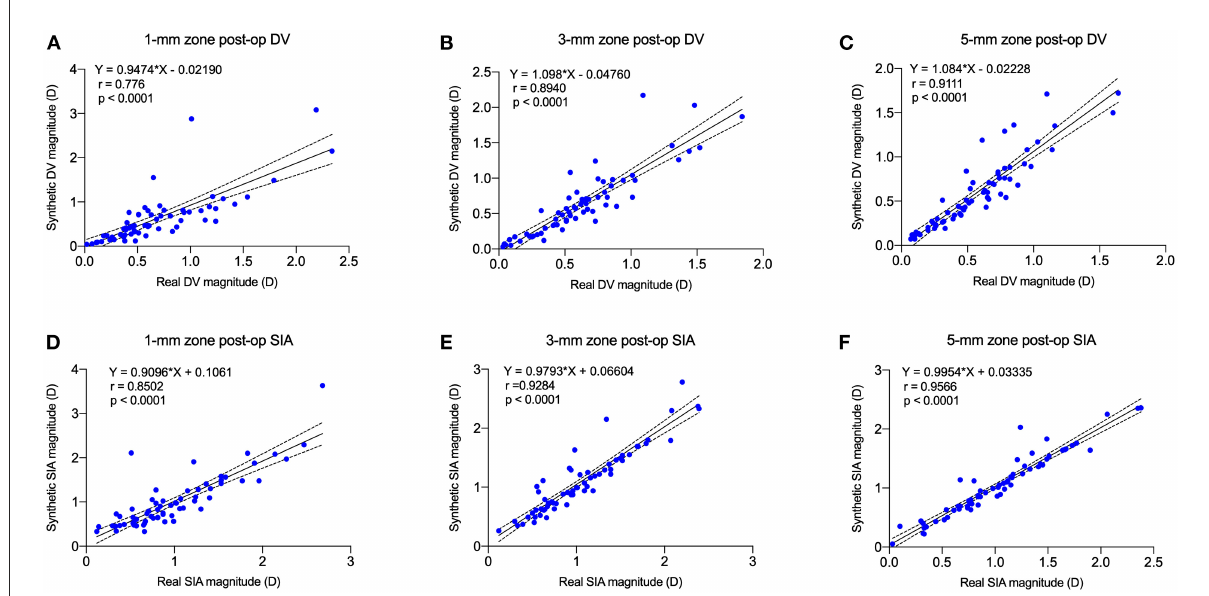
FIGURE7 Postoperative real vs. synthetic DV and real vs. synthetic SIA correlation graph for 1-mm, 3-mm, and 5-mm zones. (A) The correlation between real and synthetic DV in the 1-mm zone. (B) The correlation between real and synthetic DV in the 3-mm zone. (C) The correlation between real and synthetic DV in the 5-mm zone. (D) The correlation between real and synthetic SIA in the 1-mm zone. (E) The correlation between real and synthetic SIA in the 3-mm zone. (F) The correlation between real and synthetic SIA in the 5-mm zone.